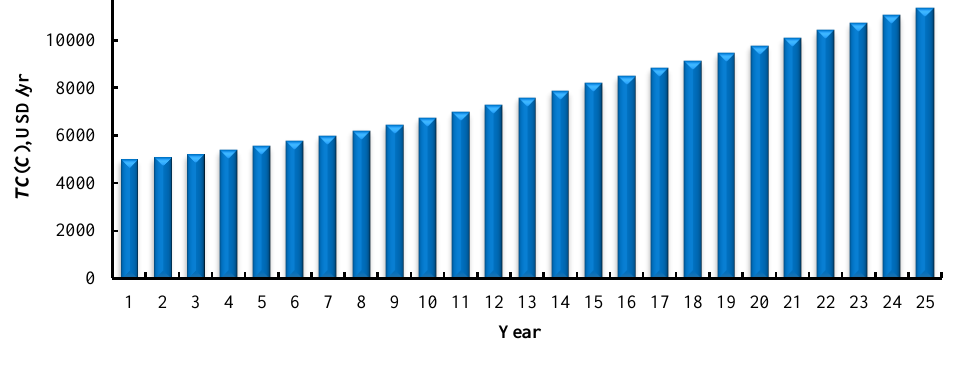
Fig. 7. The total cost of the community under 1.0ZEC design considering PV reliability.